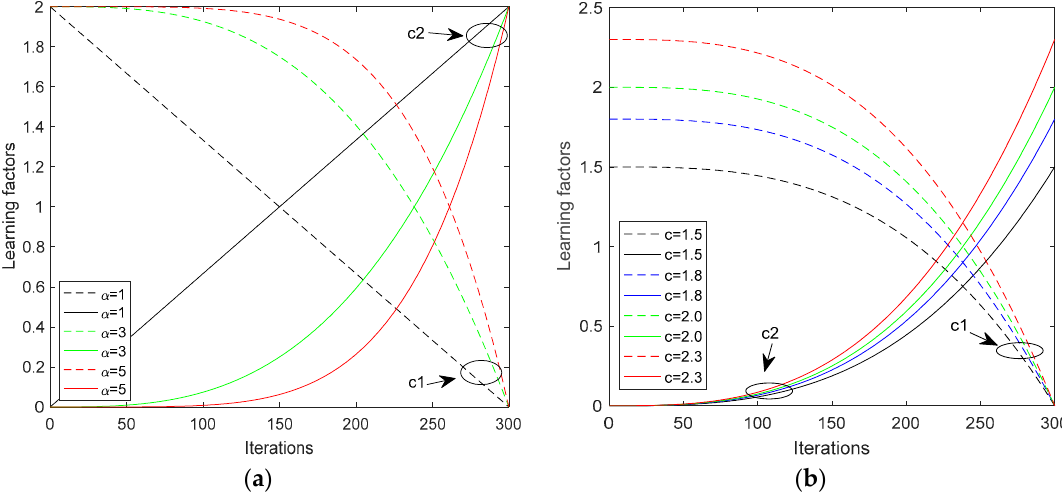
Figure 3. Curves of time-varying learning factors: ( a ) with different values of α when c = 2; ( b ) with different values of c when α = 3.